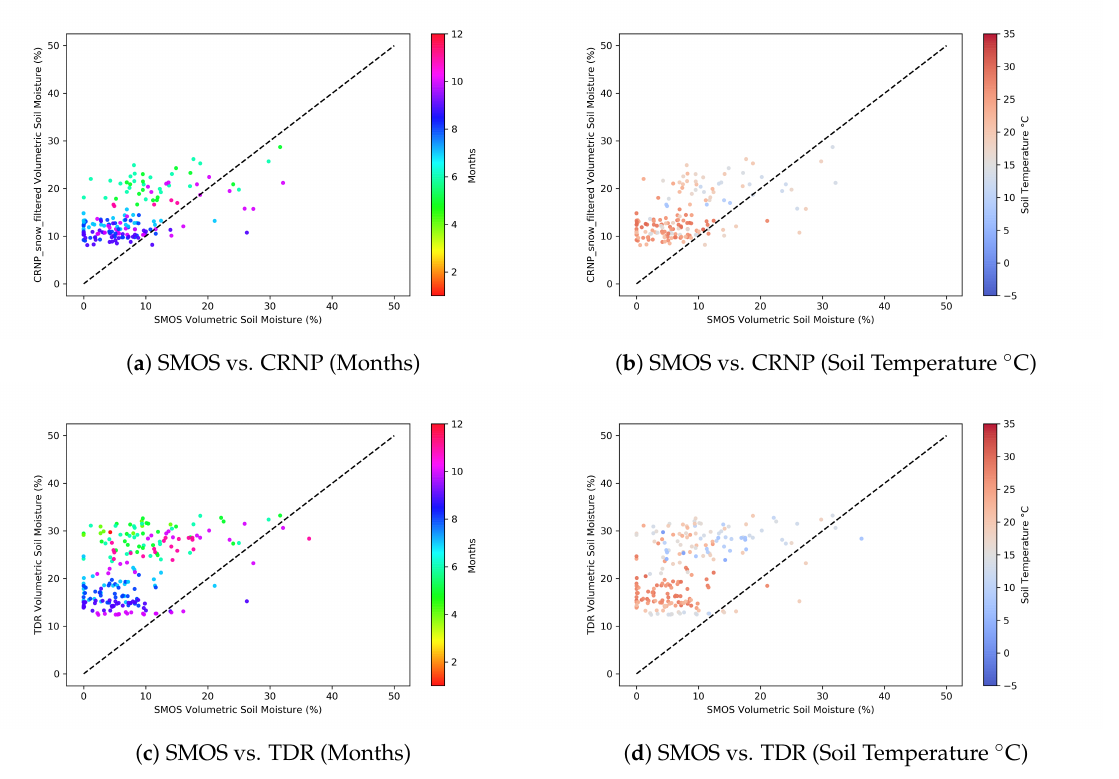
Figure A3. Comparisons between SMOS Soil Moisture Product with CRNP and TDR.